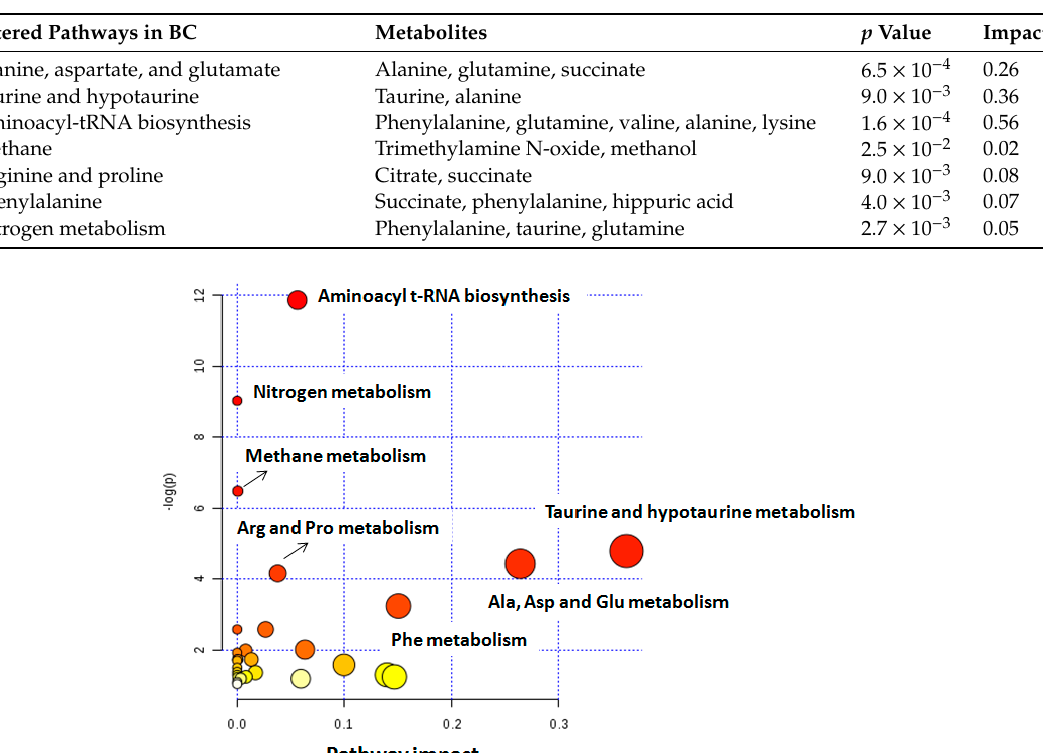
Table 3. Identified metabolites and associated altered pathways in BC urines.